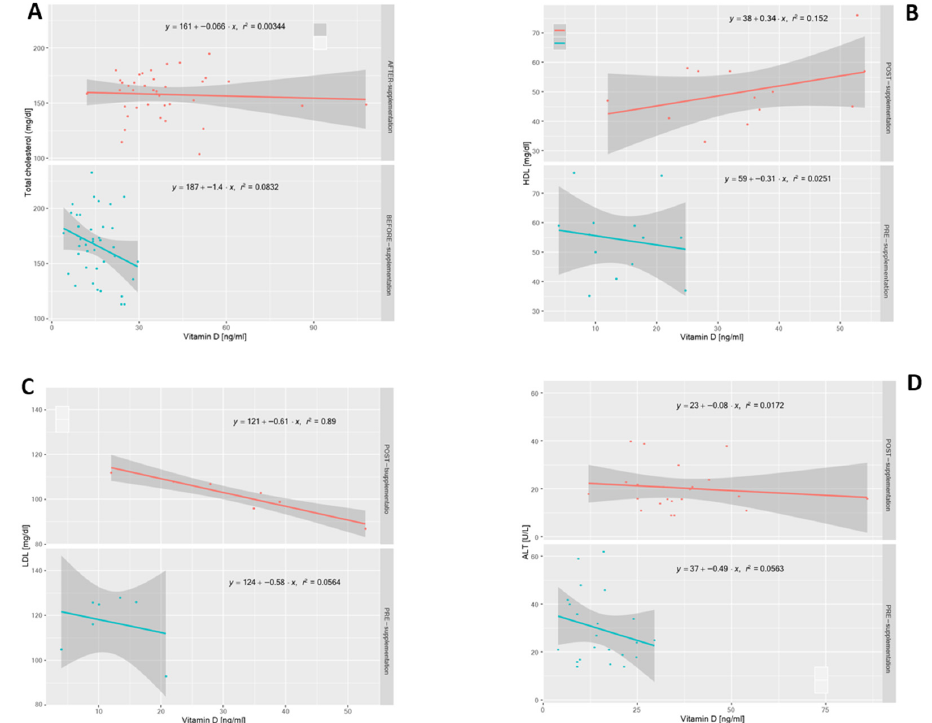
Figure 1. Linear-regression vitamin D-specific laboratory parameters before and after vitamin D supplementation: ( A ) total cholesterol; ( B ) HDL-C; ( C ) LDL-C; ( D ) ALT.